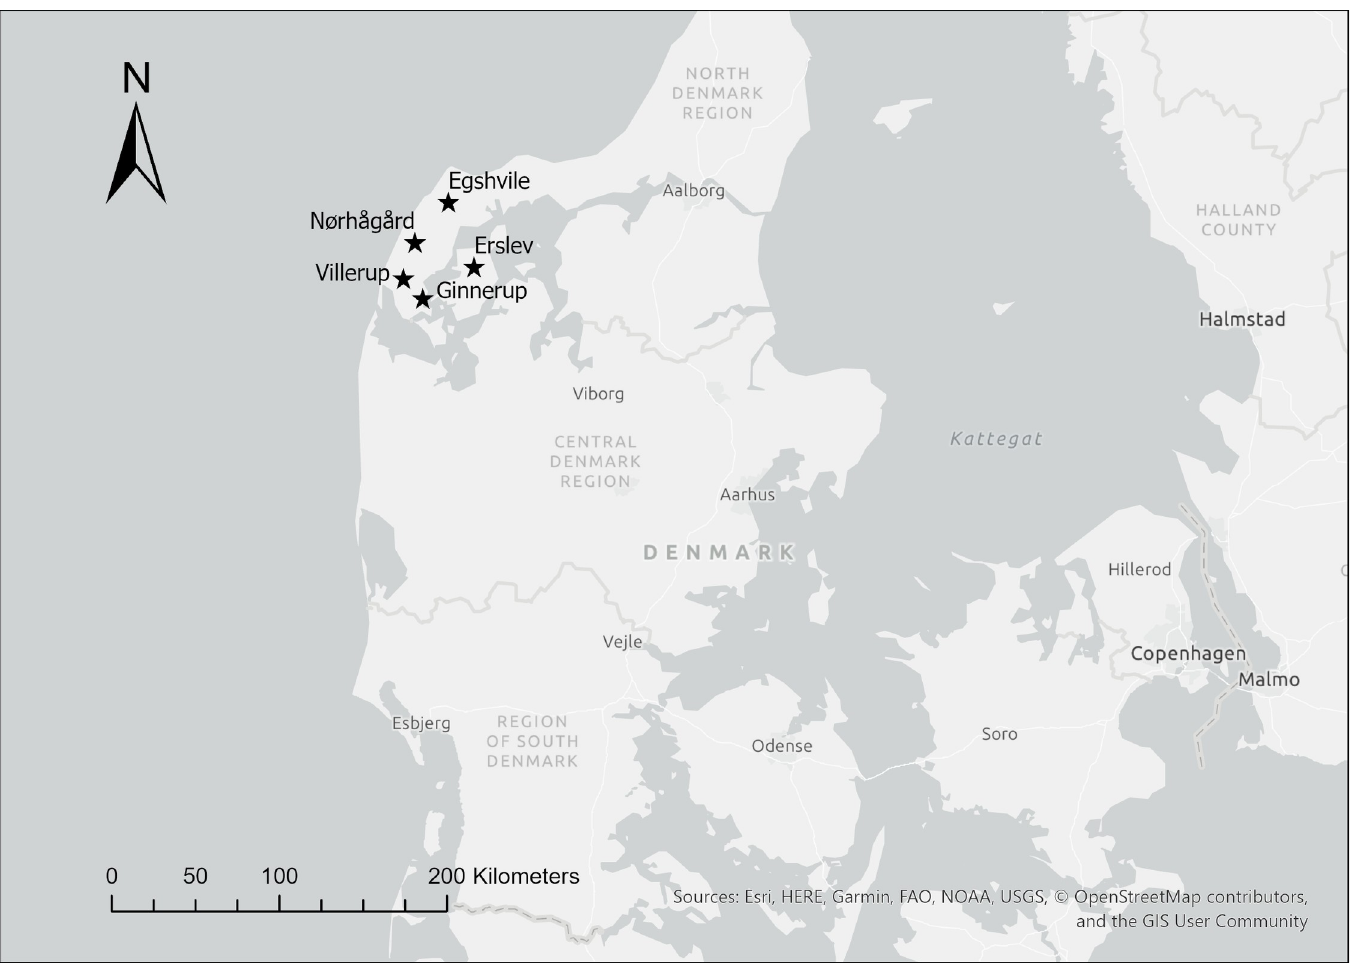
Fig 1. Map showing locations of the Early Nordic Bronze Age sites analyzed within this paper from Thisted County, Denmark. This map was generated using ESRI ArgGIS Pro software and basemaps, licensed to the National Museum of Denmark. The base map and data are from OpenStreetMap and OpenStreetMap Foundation.